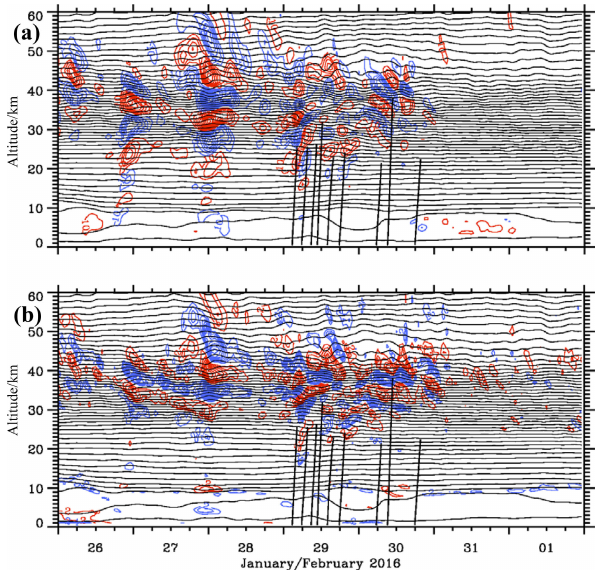
Figure 7. Altitude–time sections of the vertical wind w inms − 1 ( a , (cid:49)w = 0 . 1ms − 1 ) and temperature perturbations T (cid:48) in K ( b , (cid:49)T (cid:48) = 2K) as a composite of 1-hourly short-term HRES forecasts and 6-hourly operational analyses from the IFS cycle 41r2 above Kiruna, Sweden. Positive and negative values are plotted with red and blue lines. The temperature fluctuations are calculated rela- tive to an area mean. In panel (a) , minimum and maximum w val- ues are − 1 . 5 and 1.2ms − 1 and in panel (b) minimum and maxi- mum T (cid:48) values are ± 15K, respectively. The thin black lines are the logarithm of the potential temperature with constant increments of 0.05. The vertical black lines mark the radiosonde paths of the nine soundings mentioned in the